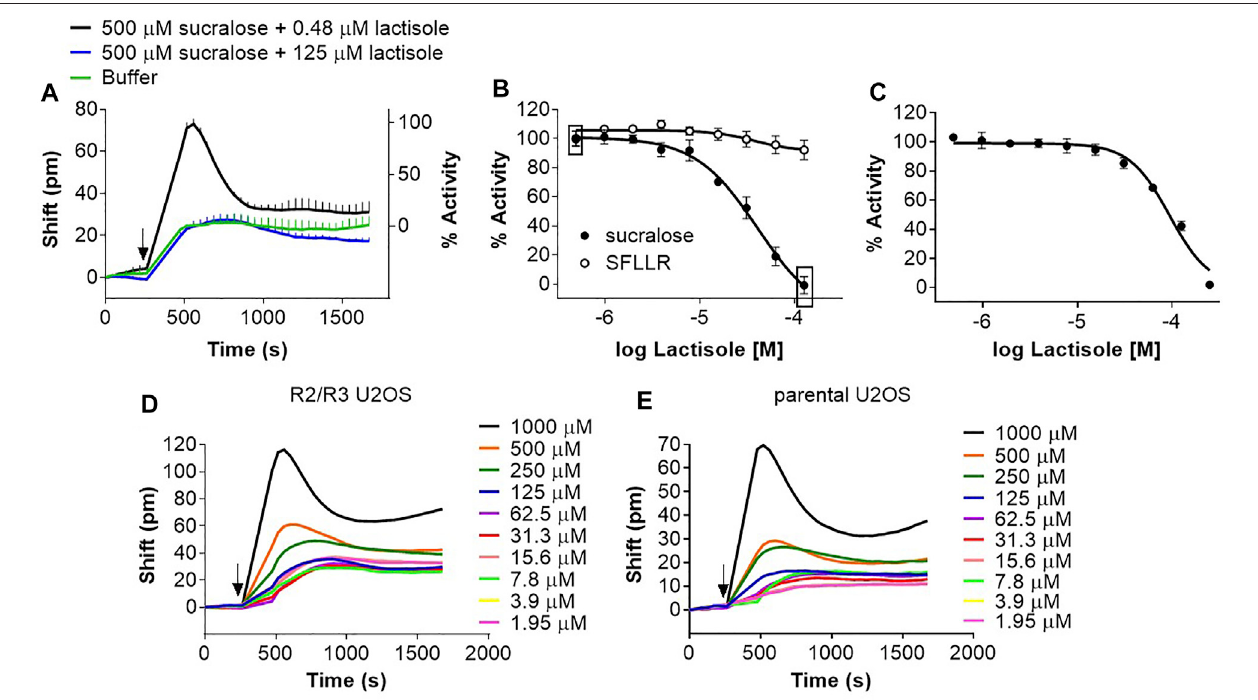
FIGURE 9 | Evaluation of a NAM for the human sweet taste receptor in the DMR and FLIPR assays. (A) R2/R3 U2OS cells were stimulated with a fi xed concentration of sucralose (500 μ M) and with increasing concentrations of lactisole and DMR responses were monitored on the Epic ® reader. Depicted are the kinetics corresponding to the effect of 0.48 μ M and 125 μ M lactisole on the sucralose effect. (B) Depiction of the full lactisole dose-responses analysis of the experiment described in (A). The rectangle includes data points from which the kinetics in Panel A were taken. (C) R2/R3 U2OS cells were transduced with G α 15 baculovirus. After 48 hours, cells were loaded with Fluo4 and stimulated with a fi xed concentration of sucralose (500 μ M) with increasing concentrations of lactisole and responses weremonitored ontheFLIPR. Curves in (B , C) arerepresentativeofthreeindependentexperimentsand datapoints correspond toanaverageandstandarddeviationof atriplicatedetermination. (D) EffectofincreasingconcentrationsoflactisoleonR2/R3U2OScells ’ basalDMRresponse.Kineticsarerepresentativeofthreeindependent experiments. (E) Effect of increasing concentrations of lactisole on parental U2OS cells ’ basal DMR response. Kinetics are representative of three independent